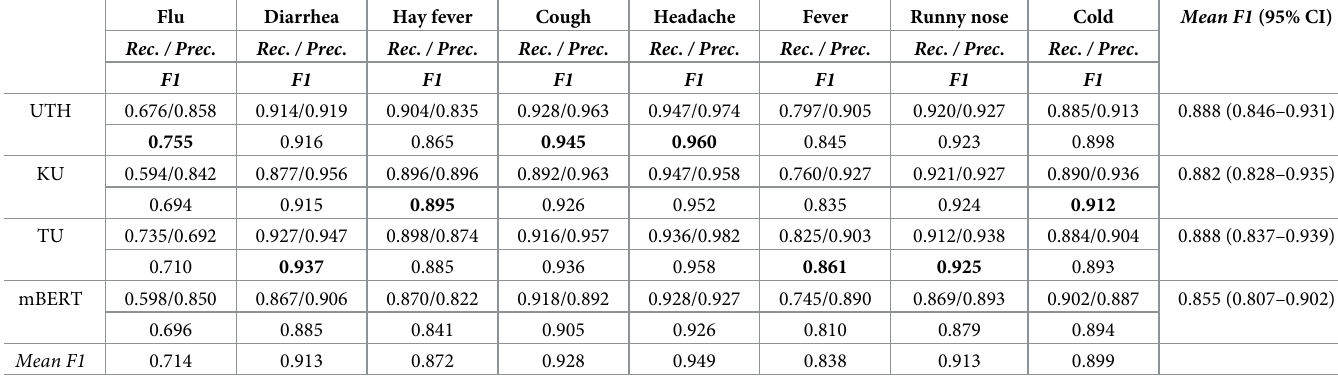
Table 5. The label-wise performances of each model with five-fold cross